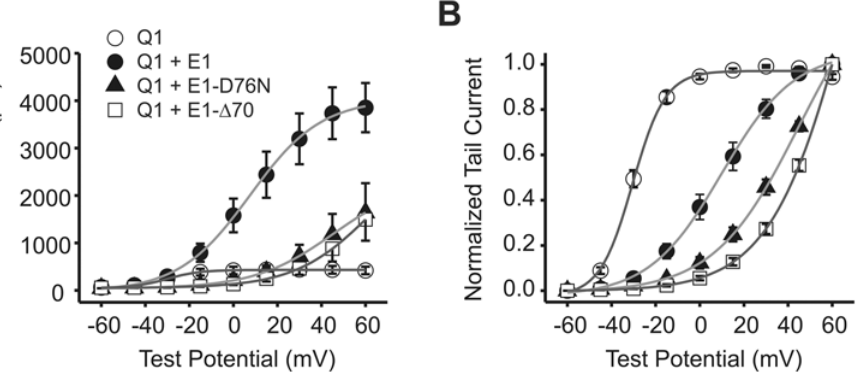
Figure 3. KCNE1-D76N and KCNE1- D 70 shift the voltage dependence of activation of I Ks . A) voltage-dependent activation curves, and B) normalized activation curves. Curves were fitted using a Boltzmann function. V h for KCNQ1= 2 30.3 6 1.0 mV, KCNQ1/KCNE1=9.5 6 4.2 mV, KCNQ1/ KCNE1-D76N=43.5 6 3.0 mV, KCNQ1/KCNE1- D 70=71.5 6 7.0 mV. n=6, p , 0.001 for both mutants compared to wild-type KCNE1.